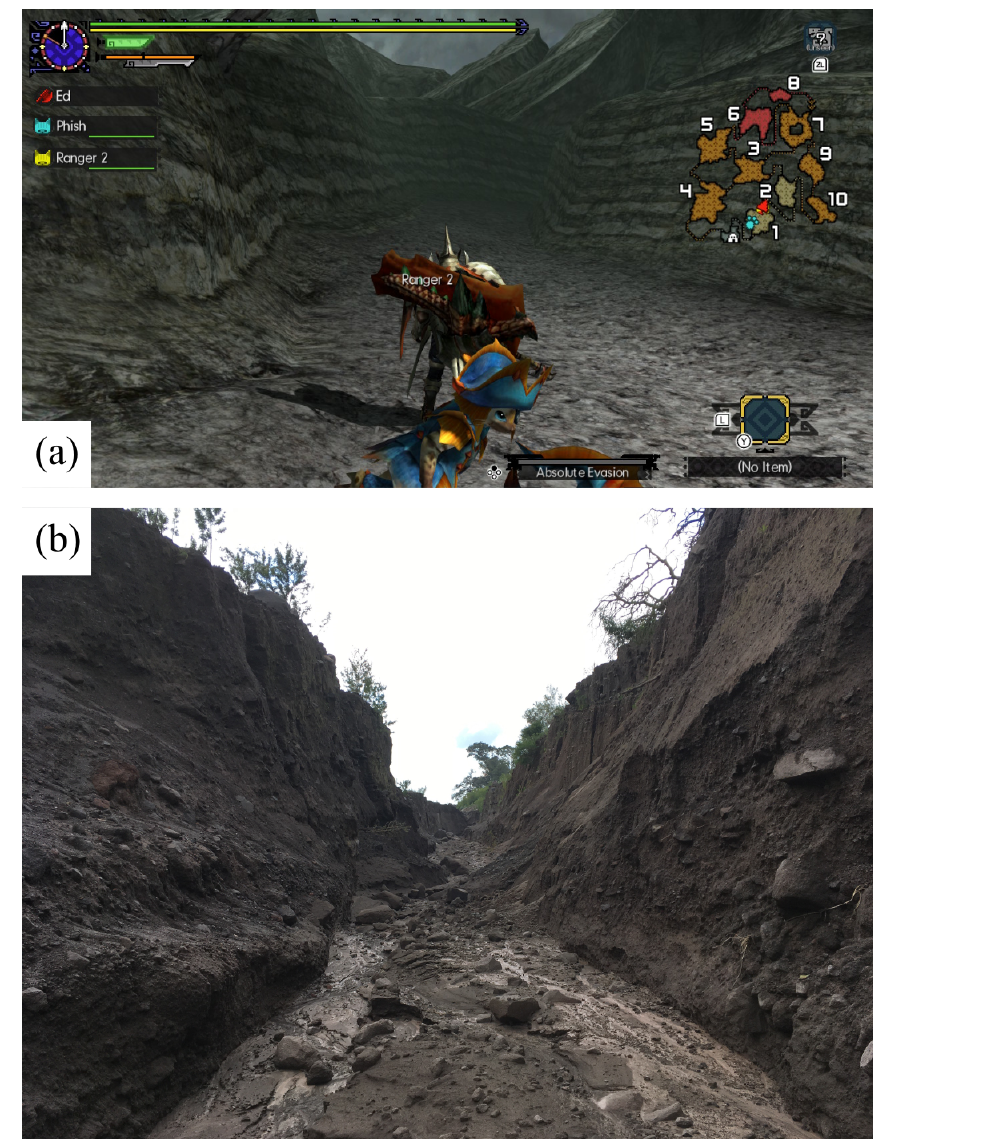
Figure 7. Art design of potential PDC deposits in Monster Hunter: Generations Ultimate © Capcom (2018; a ) compared to a real-world example of a dissected pyroclastic density current in Mexico, created by the Volcán de Colima eruption in 2015 (Edward McGowan, 2018; b